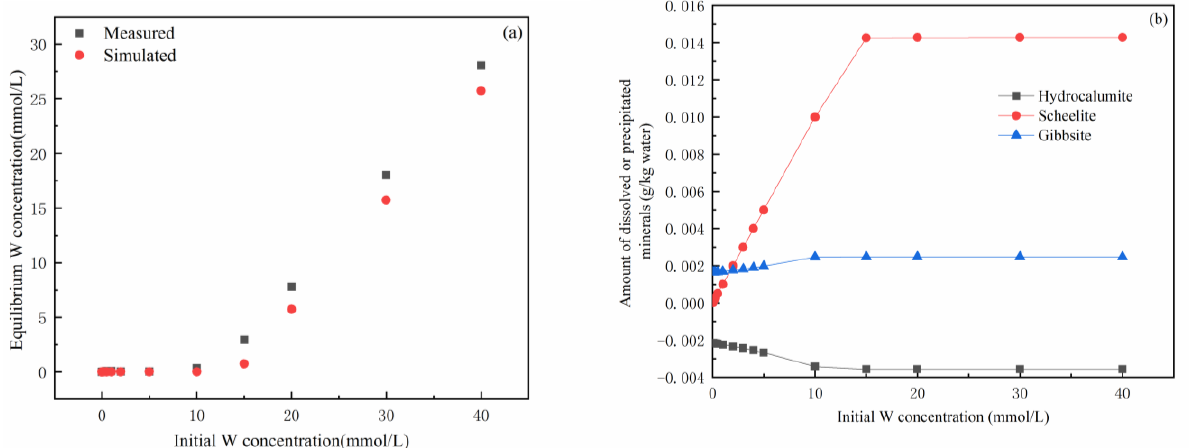
Figure 7. PHREEQC simulations. Simulated tungsten concentrations at equilibrium and their